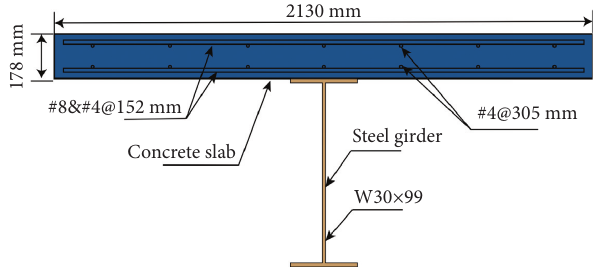
Figure 10: The cross section of the composite beams tested by Kwon et al.